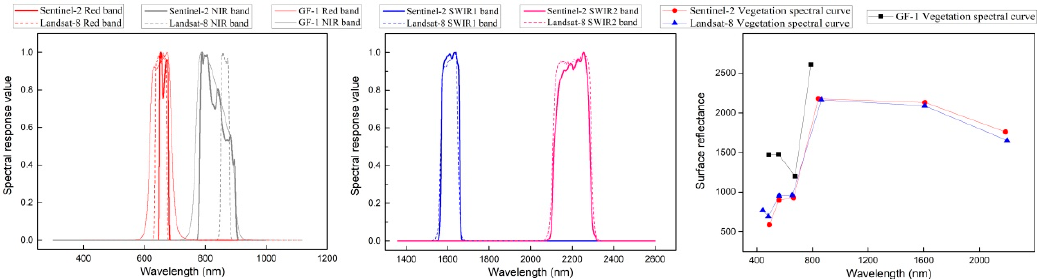
Figure 4. Spectral responses of the red, near-infrared (NIR), and short-wave infrared (SWIR1, SWIR2) bands for GF-1, Landsat-8 and Sentinel-2 (left and middle), and vegetation spectral curves of three optical sensors (right).